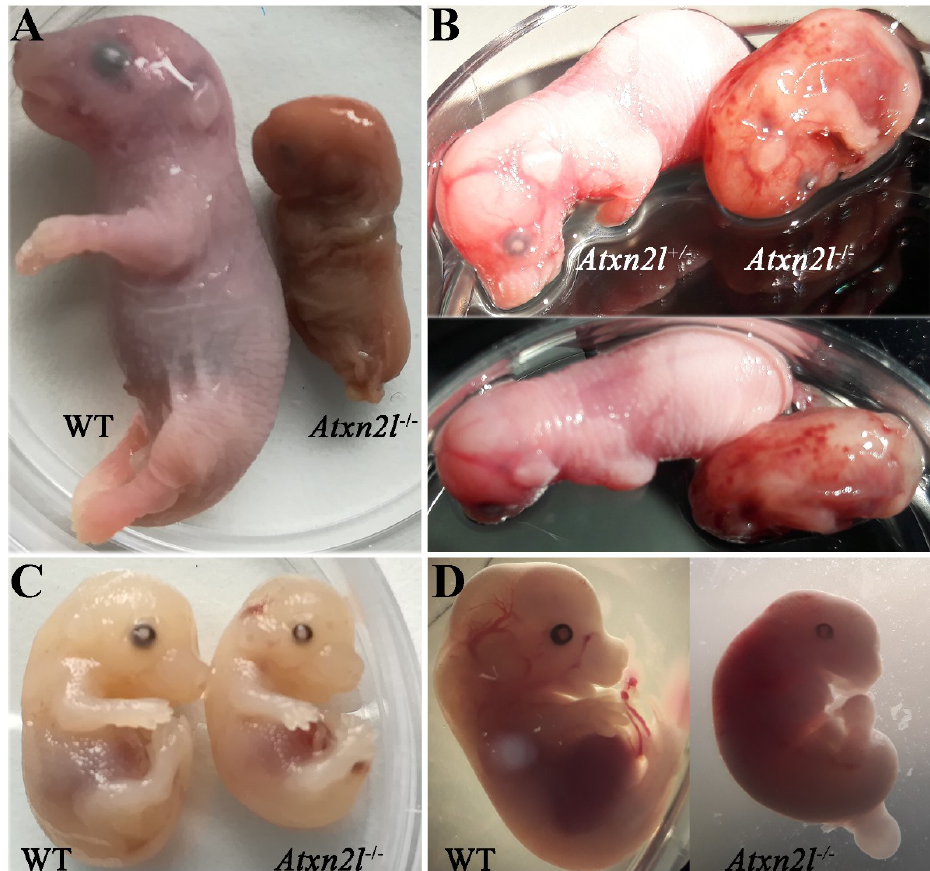
Figure 3. Comparison of Atxn2l −/− embryos with their littermates, at different gestational stages. Embryonal days reflect approximate values. ( A ) The only Atxn2l −/− mouse (male) identified at E20 in comparison to a male WT brother. ( B ) An Atxn2l −/− mouse (male) reaching E16, exhibiting retarded development, and decreased weight, in comparison to the heterozygous Atxn2l +/− female sibling. The petechial bleeds were not seen in other null mutants. ( C ) An Atxn2l −/− mouse (male) at E15-16 with liver size and blood filling similar to male WT brother. ( D ) An Atxn2l −/− female embryo at E13 with retarded growth and development and its male WT sibling.